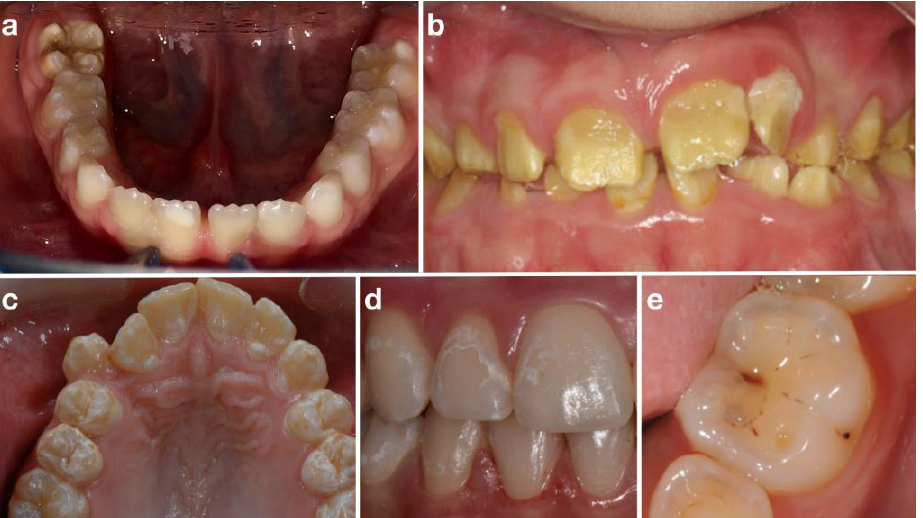
Figure 1. Clinical images showed in the questionnaire: ( a ), molar incisor hypomineralization; ( b ), amelogenesis imperfecta; ( c ), dental fluorosis; ( d ), white spot lesion; ( e ), caries lesion.